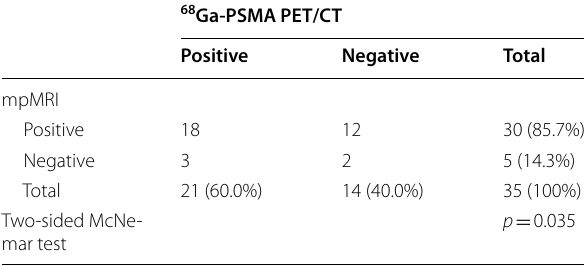
68 Ga-PSMA PET/CT, gallium-68 prostate-specific membrane antigen positron emission tomography/computed tomography mpMRI multiparametric magnetic resonance